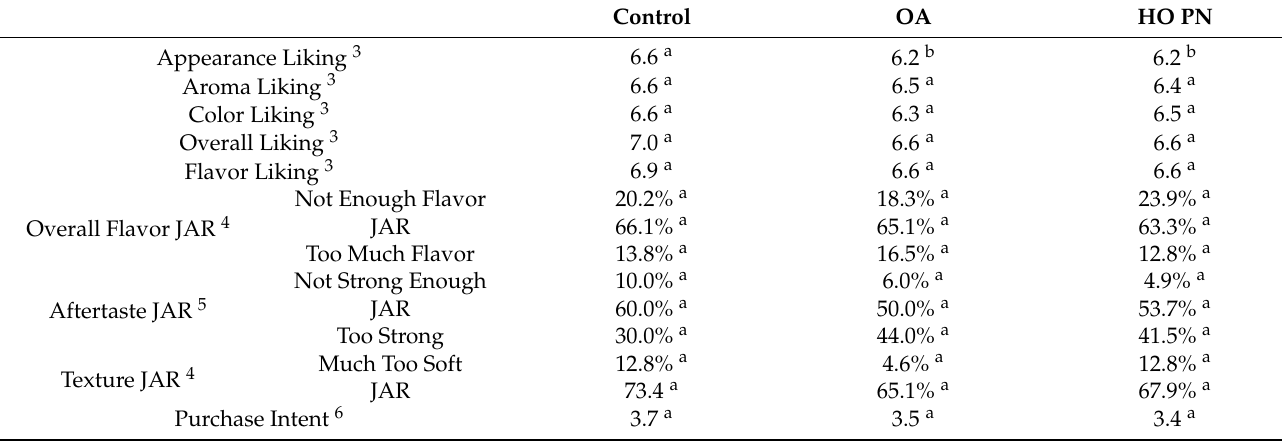
Table 7. Consumer 1 acceptance scores for scrambled egg samples produced from laying hens fed experimental diets 2